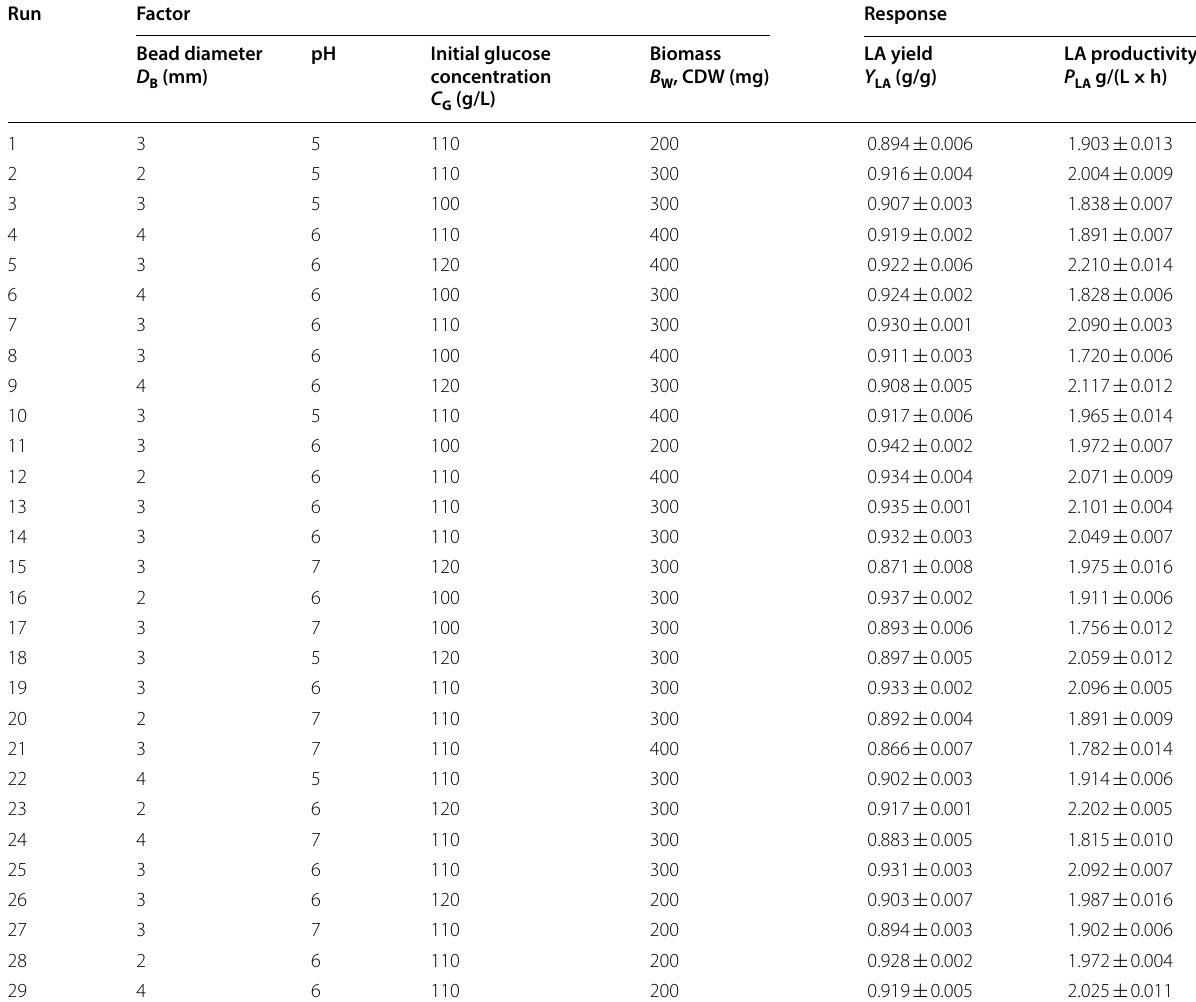
Table 3 Experimental data of LA production by immobilized L. pentosus ATCC 8041 cells Run Factor